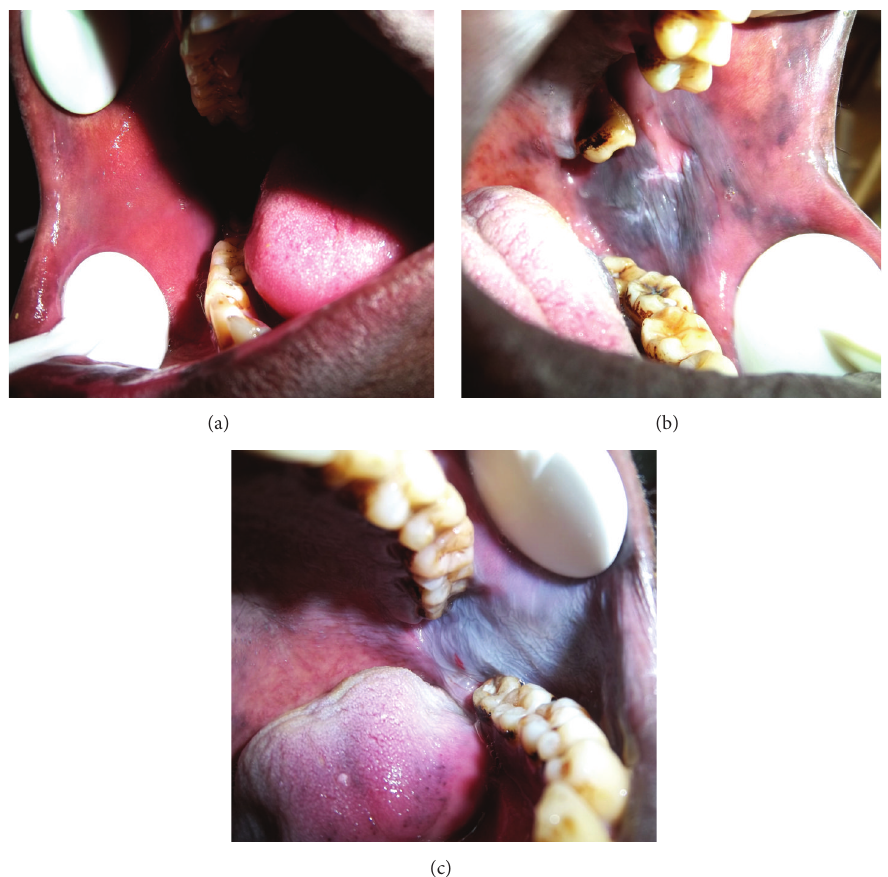
Figure 2: Clinical photographs of the buccal mucosa of some of the study participants. (a) Nonchewer (control), (b) a chronic khat chewer, and (c) a chronic khat chewer who was also a heavy